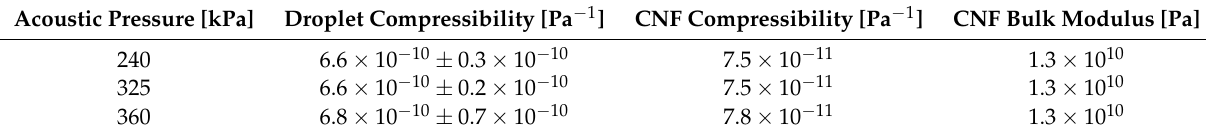
Table 3. The experimentally determined compressibilities of the Pickering-stabilized droplets at three different acoustic pressures and the theoretically estimated CNF compressibility and bulk modulus based on Equation (8) and PFP compress- ibility. In the theoretical estimation of CNF bulk modulus, it was assumed that all CNFs were adsorbed at the interface between PFP and water and that the CNF volume fraction was